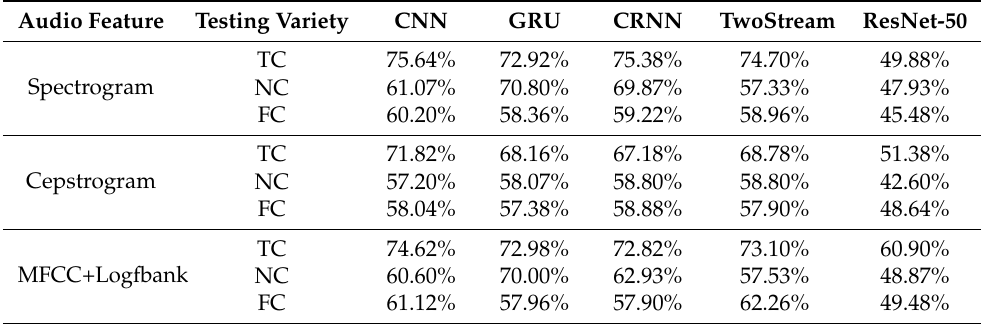
Table 4. Results of using a mixture of calls from the three varieties of chicks for training and using calls from the three varieties of chicks for